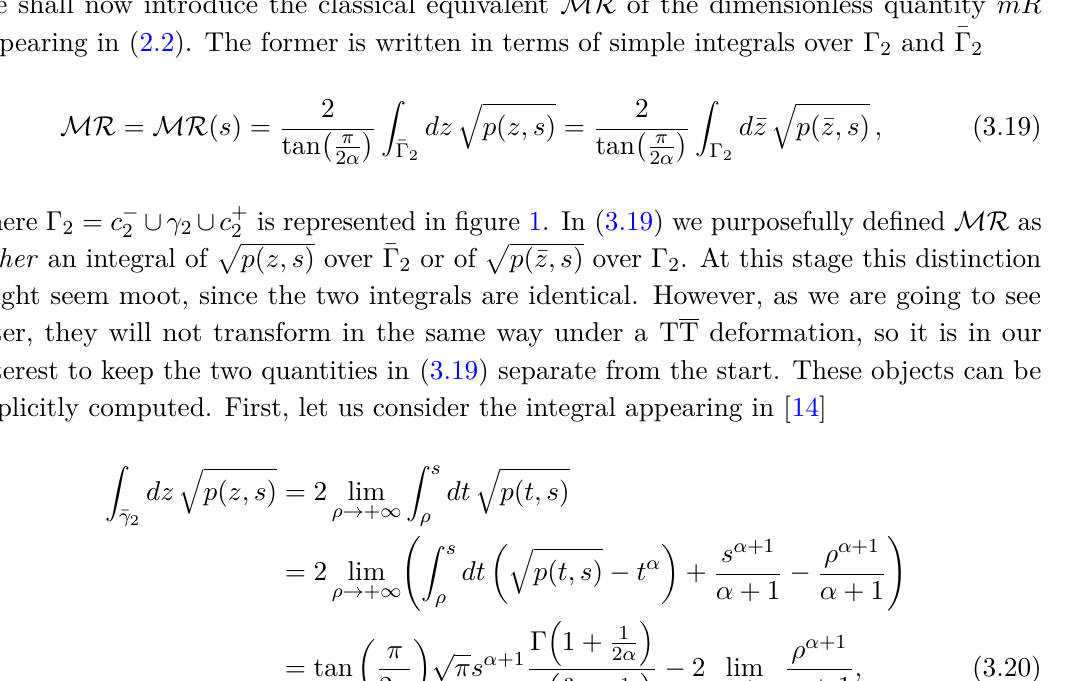
In particular, given the asymptotic requirements for the field η ( z, ¯ z ) , in the definition of the IM s J , ¯ J one can safely trade the contour Γ 2 n − 1 2 n − 1 map w ( z )